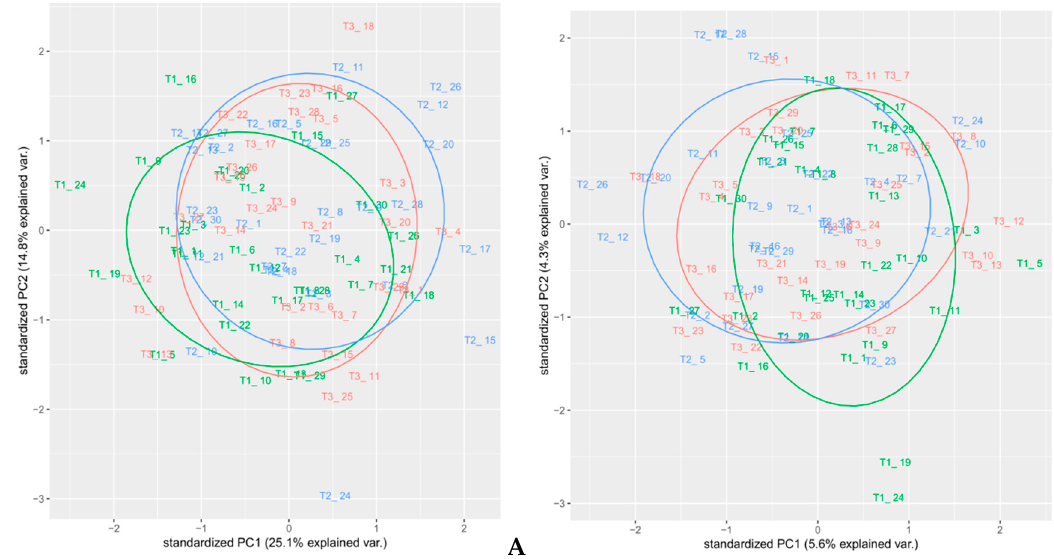
Figure 8. PCA analysis—( A ) MSC+SGD1 ( p = 1, n = 31, m = 1), and ( B ) MSC+SGD2( p = 3, n = 31, m = 2) pre-treatments.